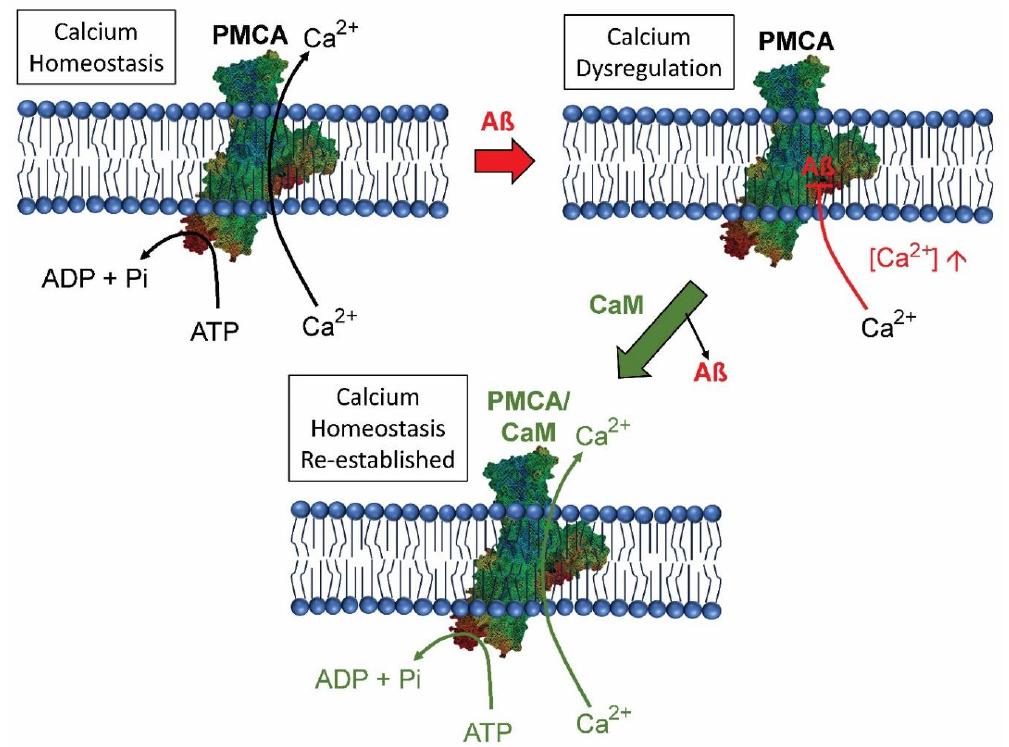
Figure 3. The regulation of PMCA and calcium levels by amyloid beta (Aβ) and calmodulin (CaM). The calcium-pump PMCA is critical to calcium homeostasis. In the presence of Aβ, PMCA binds to and is inhibited by the neurotoxic peptide, leading to a buildup of intracellular calcium. CaM does not only bind to A β , it also significantly increases the calcium pump activity of PMCA. While describing re-establishing calcium-homeostasis caused by A β